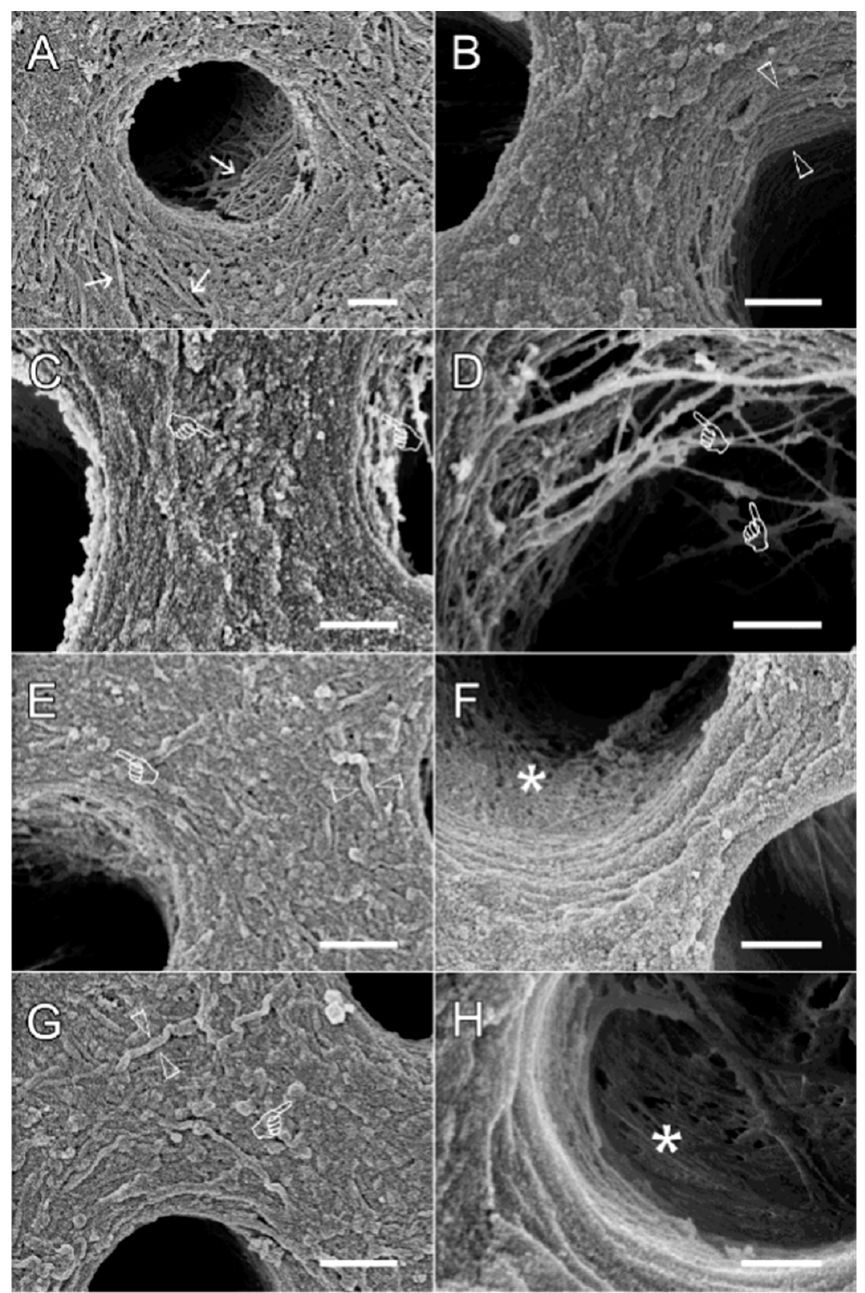
Figure 2. Representative SEM micrographs of the etched dentin resulting from different biomod- ification procedures. Images showing an illustrative area of the dentin surface of ( A ): DW group, intertubular and peritubular dentin collagen fibers (white arrows), different diameters of dentin colla- gen fibers (triangular arrows); ( B ): EDC group; ( C , D ): 1 mg/mL TMC + EDC group, TMC particles (finger); ( E , F ): 5 mg/mL TMC + EDC group, TMC particles (finger), collagen fibers (triangular arrow); ( G , H ): 10 mg/mL TMC + EDC group, membrane-like structure (asterisk). Scale bar = 500